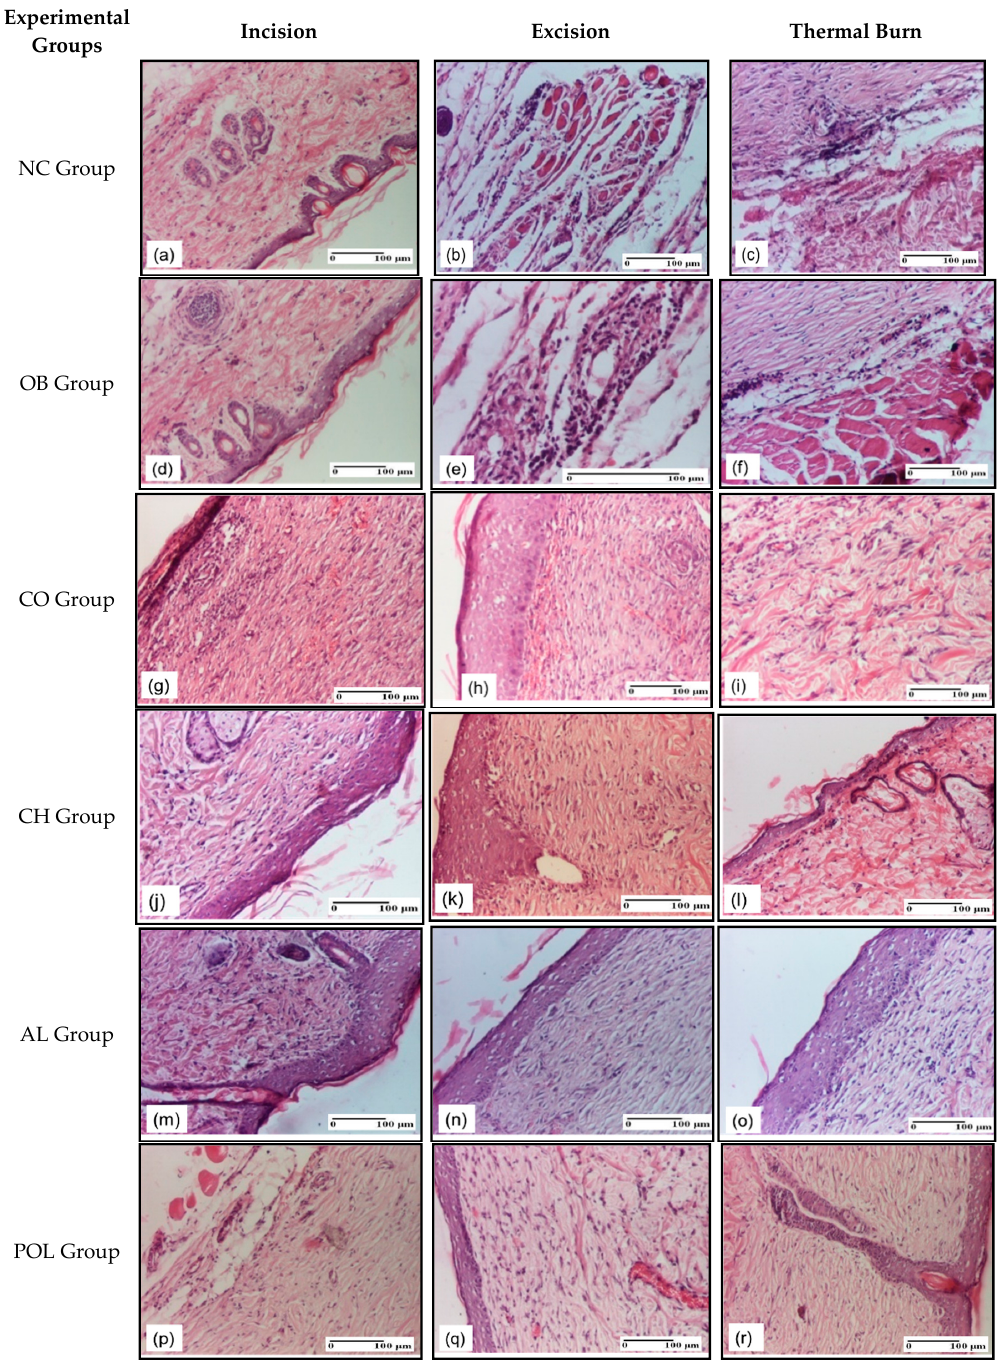
Figure 8. Microscopic histology images on day 21: ( a ) Edema (S1); ( b ) Inflammation in striated muscle (S2); ( c ) Inflammatory infiltrate (S2, D0); ( d ) Edema (S1); ( e ) Inflammatory infiltrate in hypodermis (S2); ( f ) Inflammatory infiltrate (S2, D0); ( g ) Mature granulation tissue (S2); ( h ) Significant dermal collagenization (S1); ( i ) Dermal collagenization (S1, D0); ( j ) Dermal collagenization (S1); ( k ) Dermal collagenization (S1); ( l ) Dermal collagenization (S1, D0); ( m ) Dermal collagenization (S1); ( n ) Mature granulation tissue, dermal collagenization (S1); ( o ) Significant dermal collagenization due to the maturation of granulation tissue (S2, D0); ( p ) Significant dermal collagenization (S1); ( q ) Slight dermal collagenization (S1); ( r ) Significant dermal collagenization (S1, D0). Inflammatory infiltration scoring: S0 (no inflammatory infiltrate), S1 (mild inflammatory infiltrate), S2 (moderate inflammatory infiltrate), S3 (severe inflammatory infiltrate). The thermal burn depths (D): D0– normal skin, D1–epithelial necrosis within the epidermis, the basement membrane remains intact, D2–necrosis of skin appendages and dermal connective tissue; D3–extensive necrosis within the hypodermic